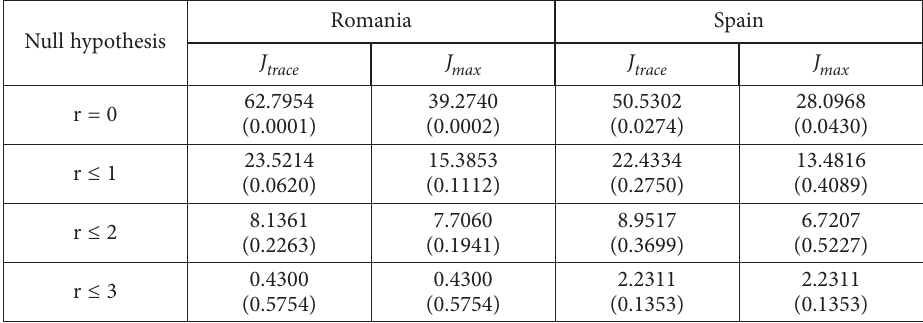
Table 2. Johansen cointegration test Romania Spain Null hypothesis J trace J max J